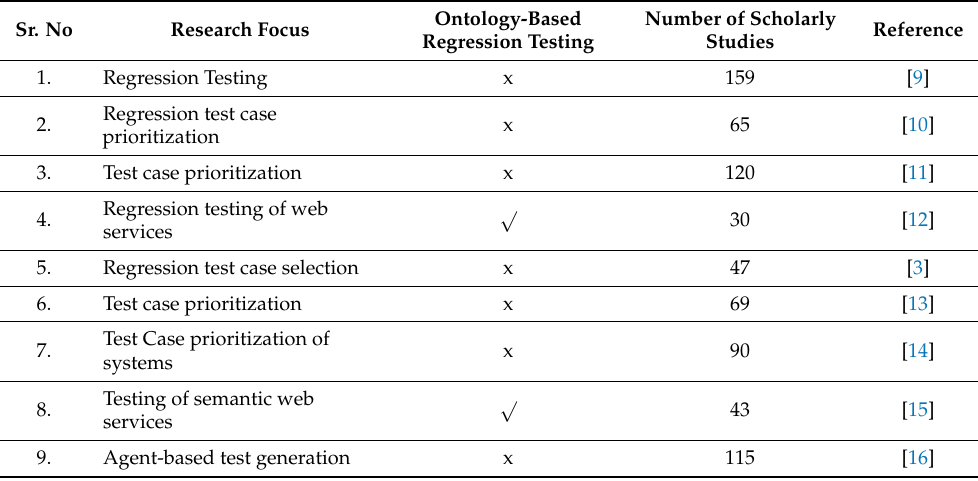
Table 1. Existing SLRs on regression